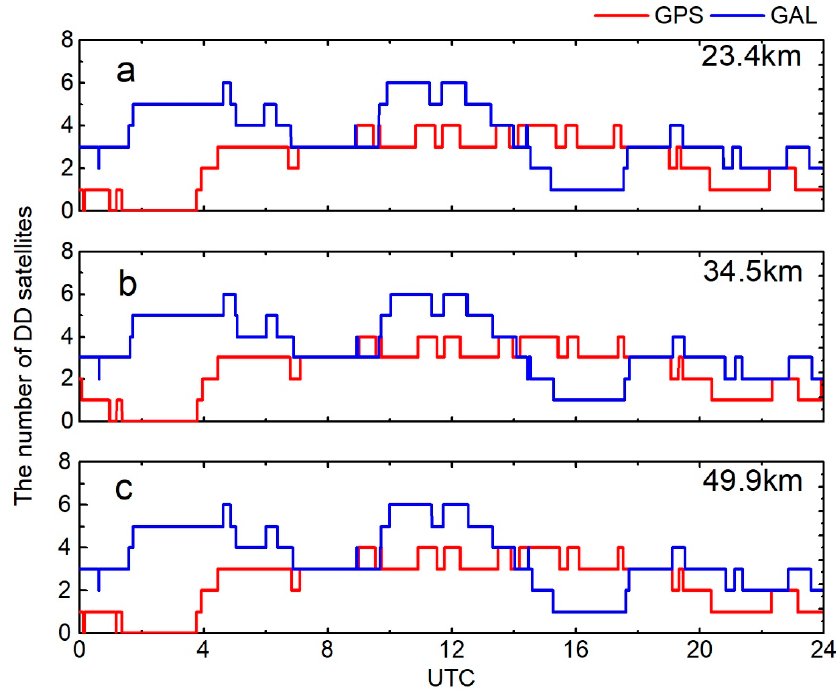
Figure 10. The number of DD satellites in three baselines on DOY 001, 2018 ( a ): 23.4 km; ( b ): 34.5